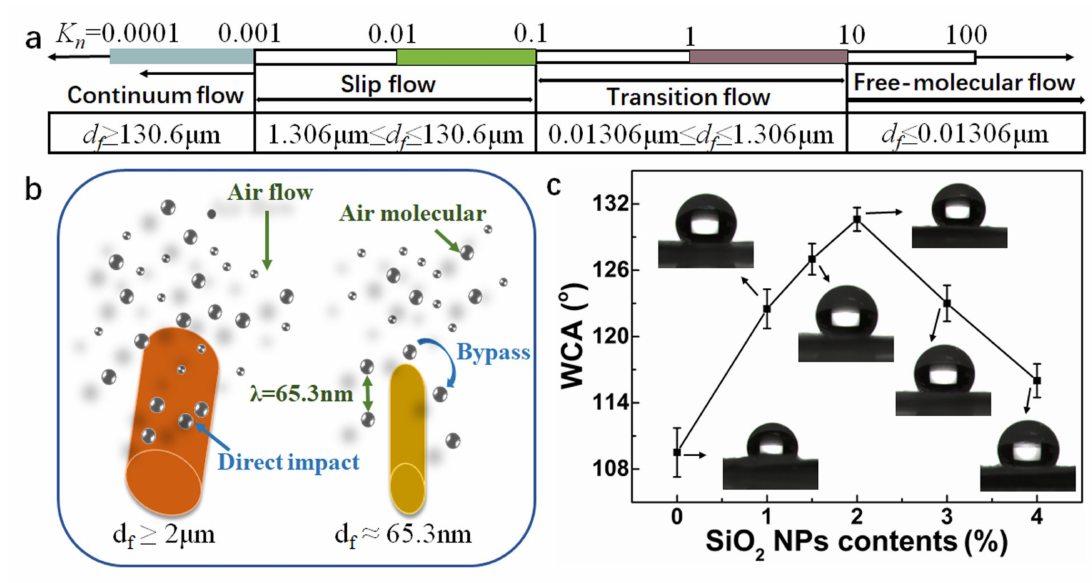
Figure 3. ( a ) The schematic representation of the scale bars of flow regime. ( b ) Schematic showing the mechanism of slip flow. ( c ) WCAs and the selected optical profiles of water droplets on various SiO 2 @PI hybrid membranes.